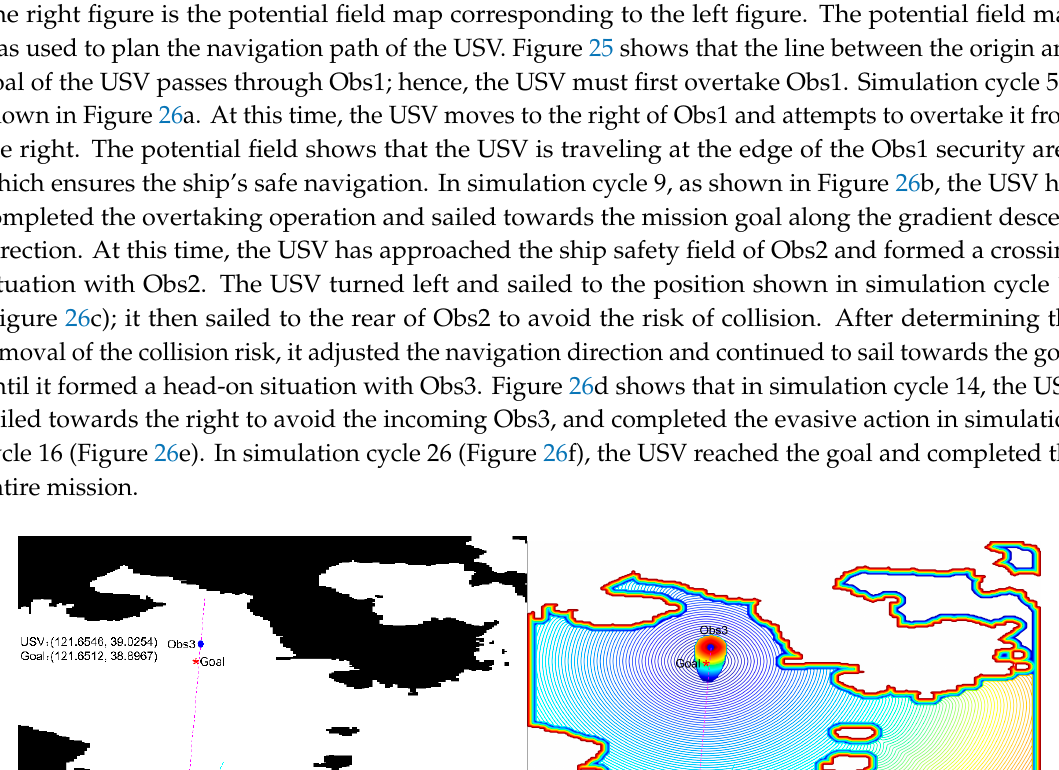
Figure 25. Initial situation of local dynamic planning: ( a ) original map; ( b ) potential field diagram.